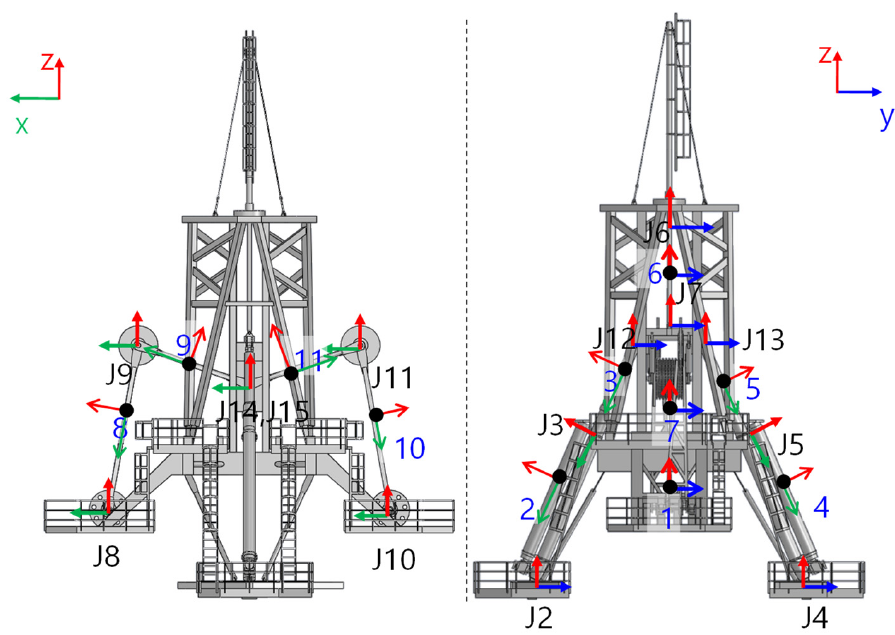
Figure 11. Joints and coordinate systems of heave compensation system.